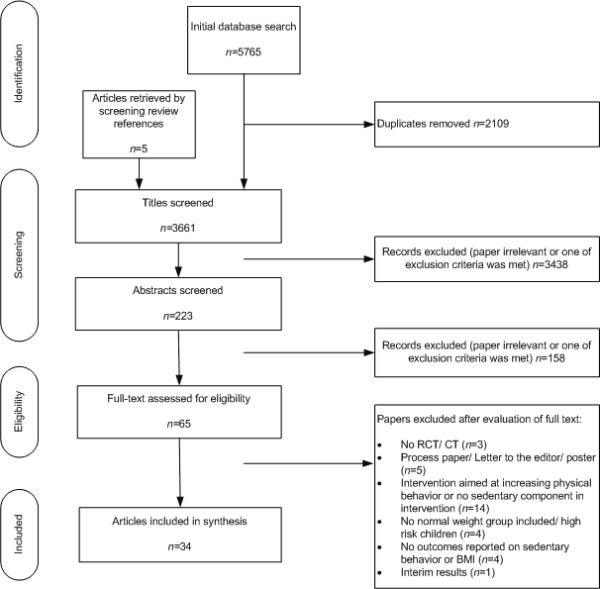
Flow chart of the study selection process.